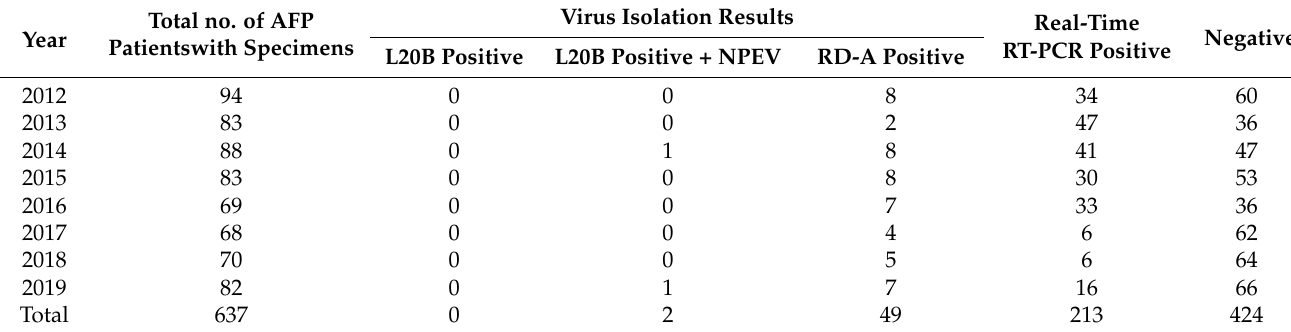
Table 3. Virus detection during AFP surveillance in Korea, 2012–2019.